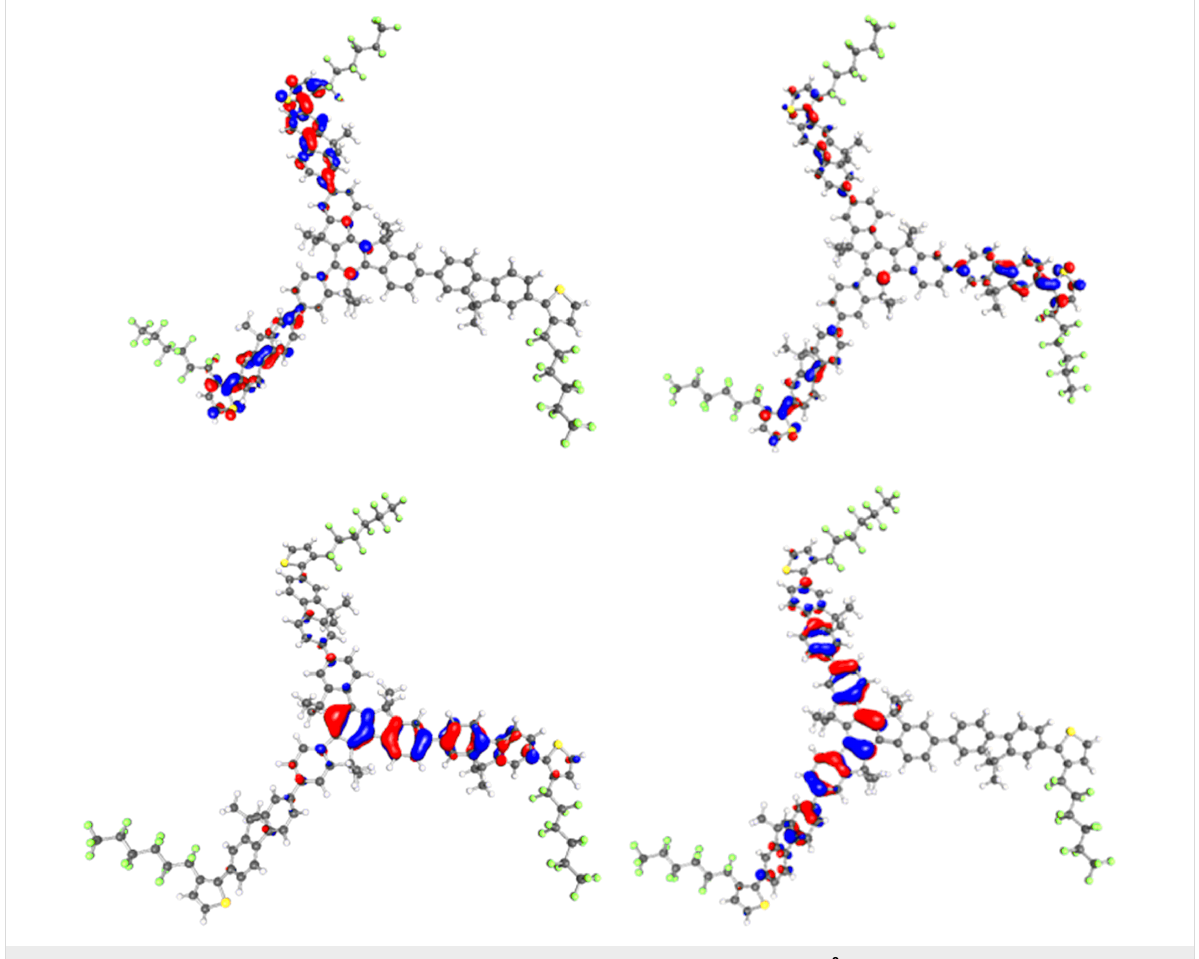
Figure 3: HOMO − 1 (bottom, left), HOMO (bottom, right), LUMO (top, left) and LUMO+1 (top, right) of T1- 3 FTh .